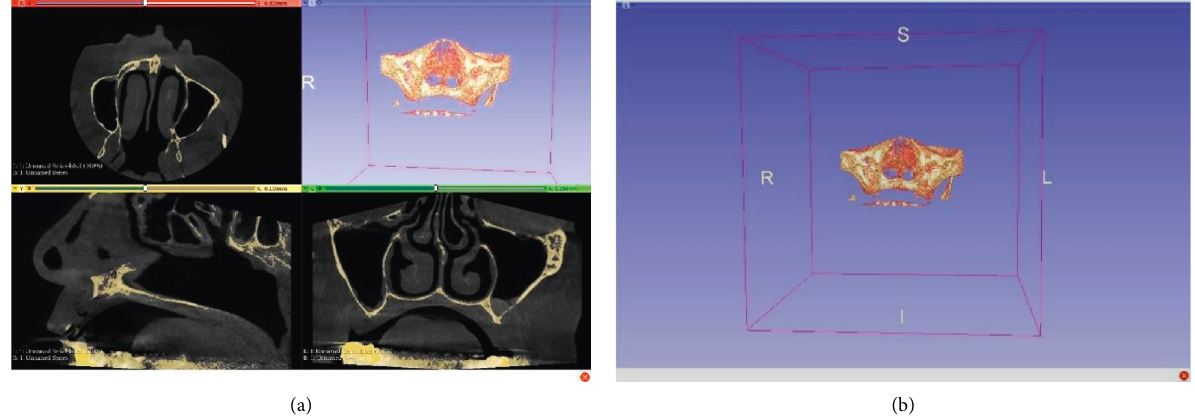
Figure 1: (a) Segmentation of DICOM data and (b) 3D image generated after segmentation.